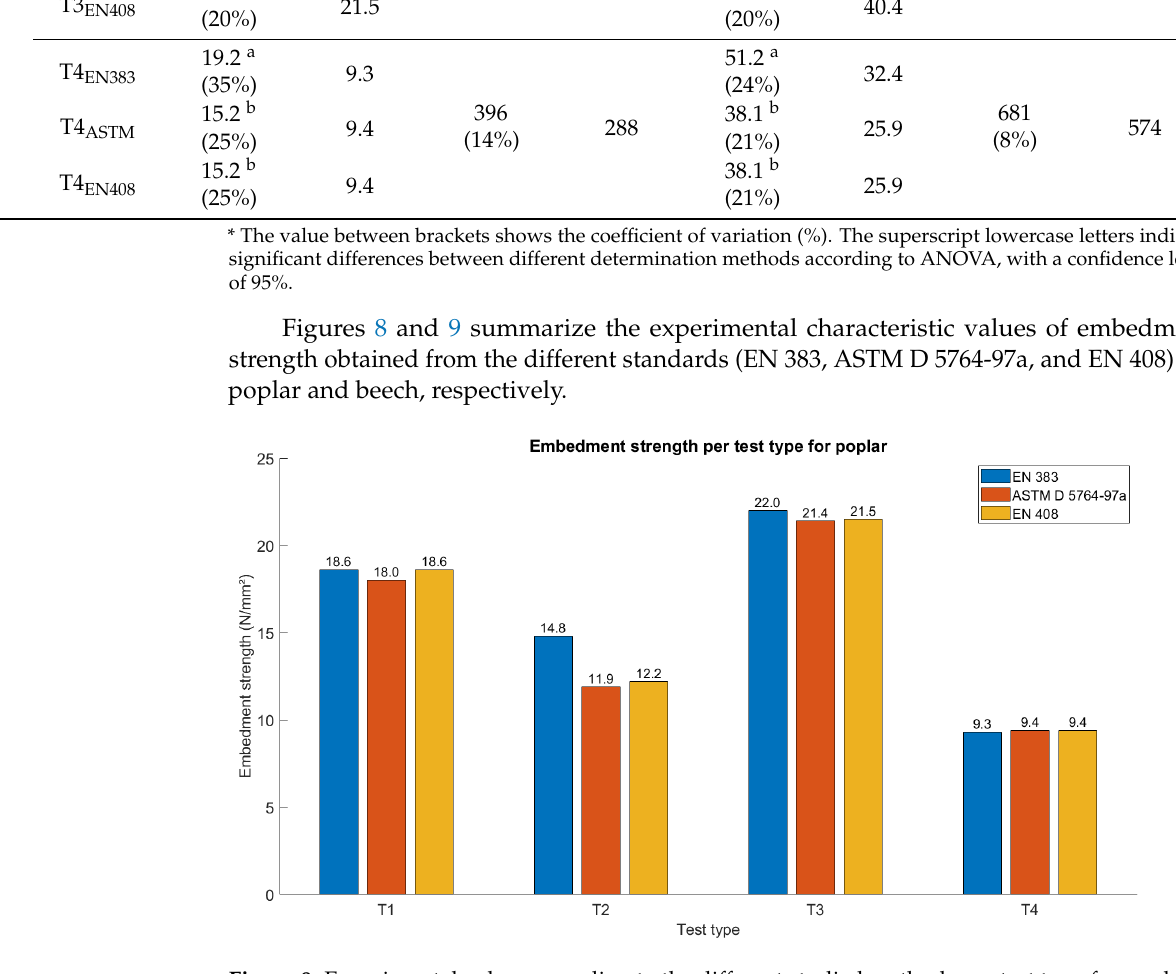
Figure 9. Experimental values according to the different studied methods per test type for beech. In poplar, it can be observed from Figure 8 that experimental values obtained through the three different methods are similar for the two parallel to grain tests per- formed, and for the perpendicular to grain test with bolts. However, values of perpendic- ular to grain embedment strength with screws evaluated according to EN 383 standard were higher compared with the ones of the other two methods. The same tendency seen in parallel to grain tests with both types of connectors for poplar can be seen for the case of beech. In this case, regarding perpendicular to grain tests, higher values are obtained according to the EN 383 method for both types of con- nections. In particular, in tests with screws, perpendicular to grain embedment strength was even higher than the parallel to grain one. Therefore, due to the hardening behavior of timber when tested in the perpendicular direction to grain, perpendicular embedment strength could be heavily overestimated if it was determined according to the method provided by the EN 383 standard.